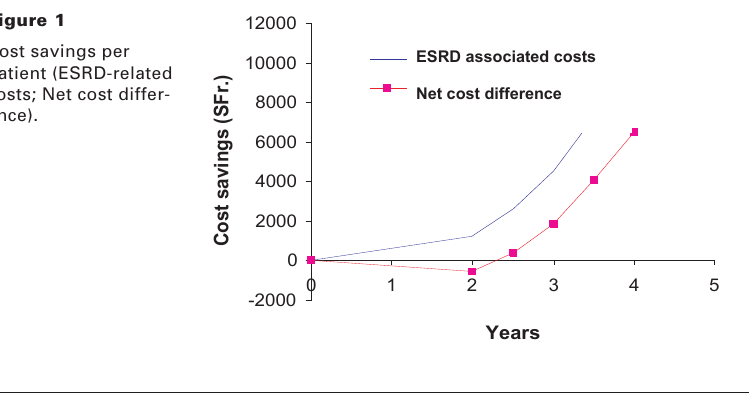
Univariate sensitivity